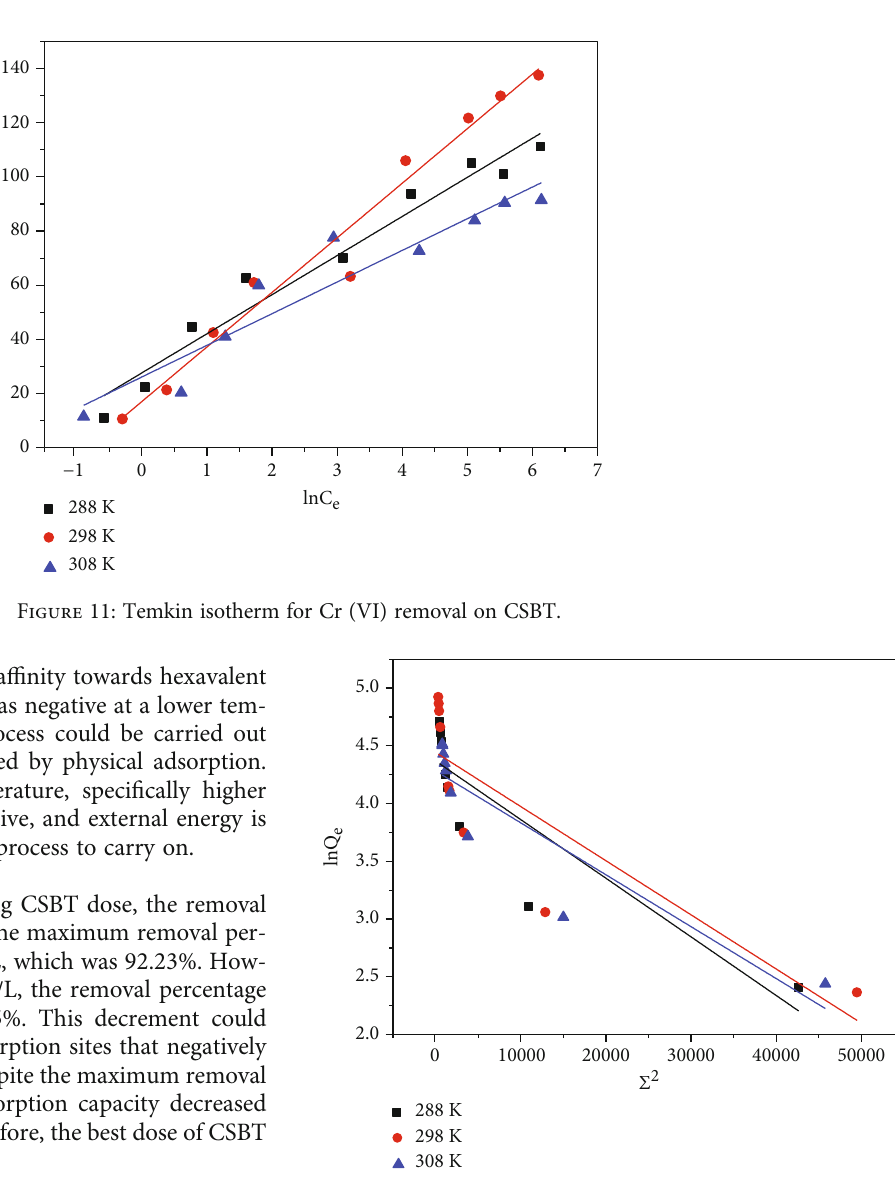
Figure 12: D-R isotherm for Cr (VI) removal on